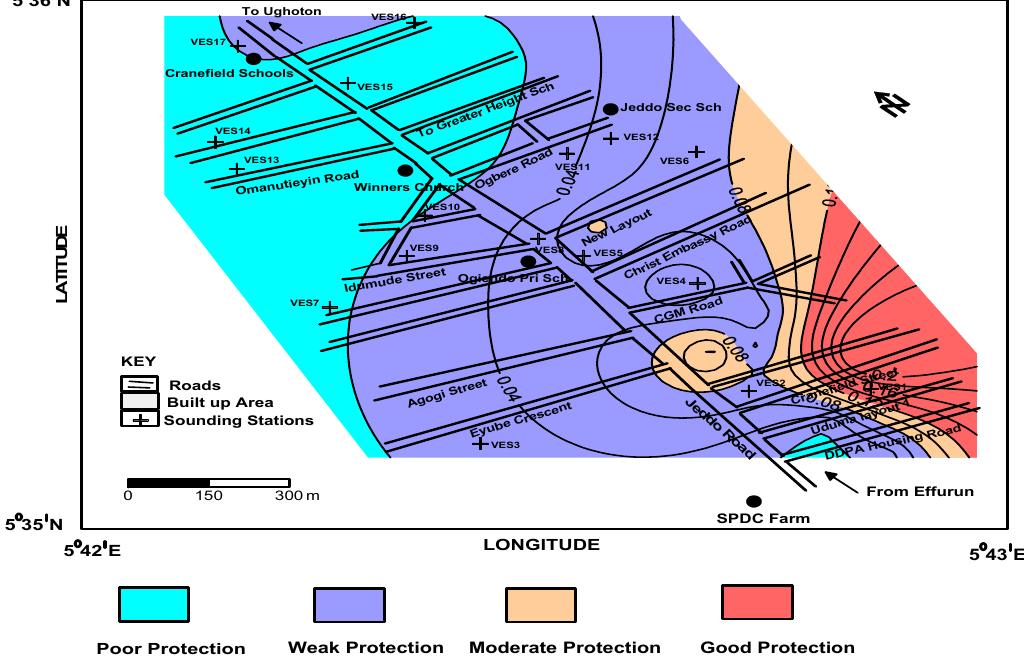
Figure 6. Map of aquifer protective capacity.